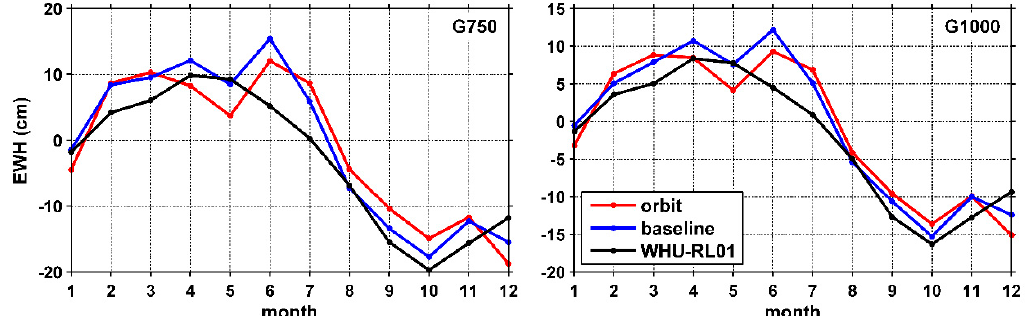
Figure 7. Time series of mean mass anomalies over the Amazon river basin inferred from the G750 (left) and G1000 (right) filtered solutions in 2010. Table 4. Correlation coefficients and RMS differences (cm) between mass anomaly time series over the Amazon river basin inferred from the GPS-based solutions and WHU RL01.